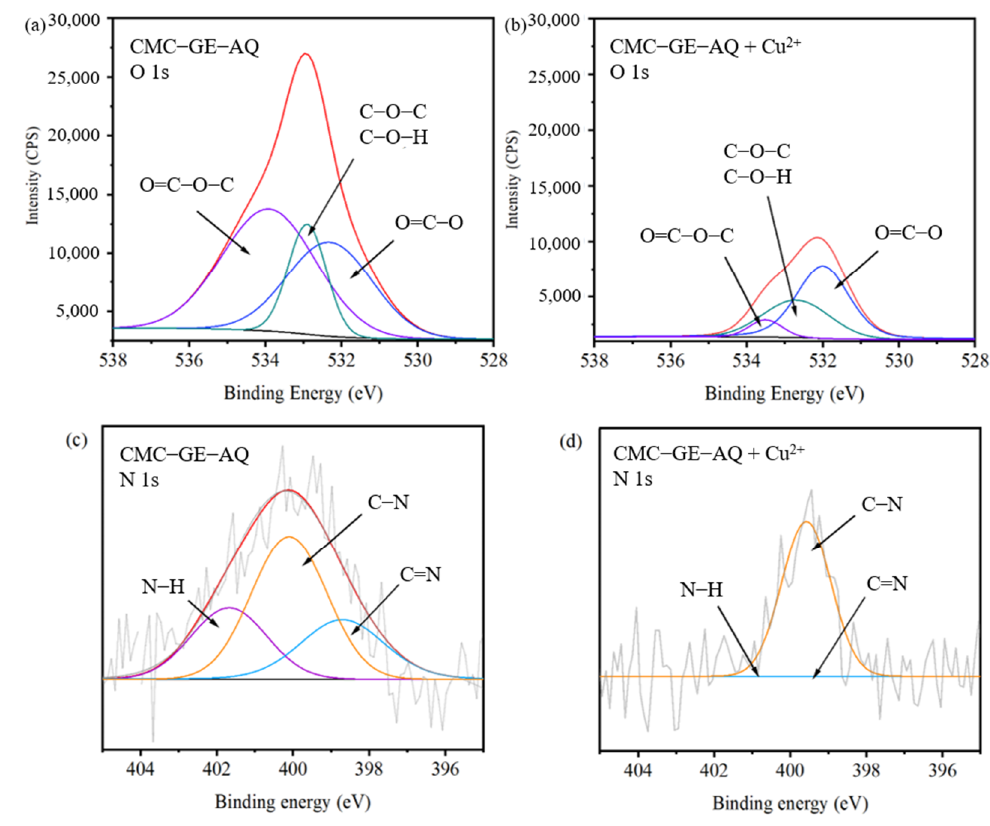
Figure 10. High resolution XPS spectra of ( a , b ) O 1s and ( c , d ) N 1s of CMC−GE−AQ and CMC−GE−AQ + Cu 2+ .